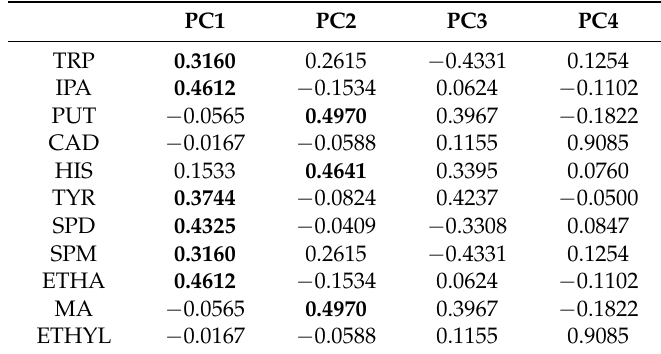
Table 6. Loading values for PCA.